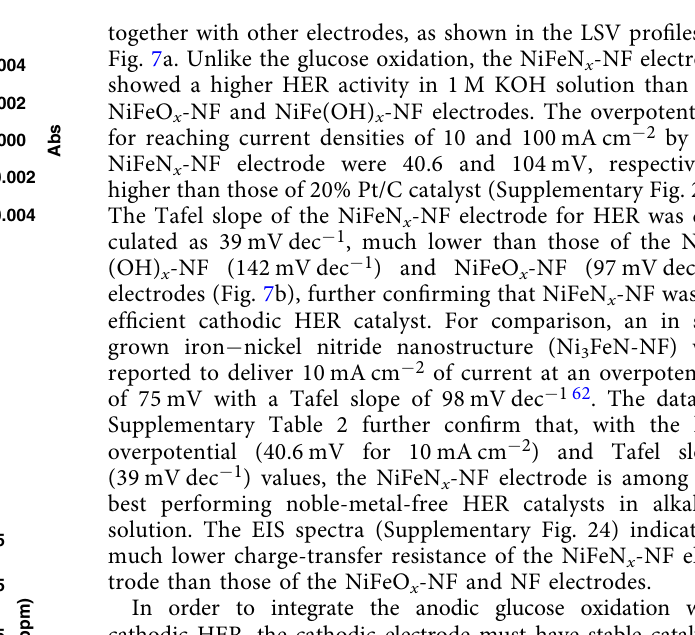
Glucose cycle form